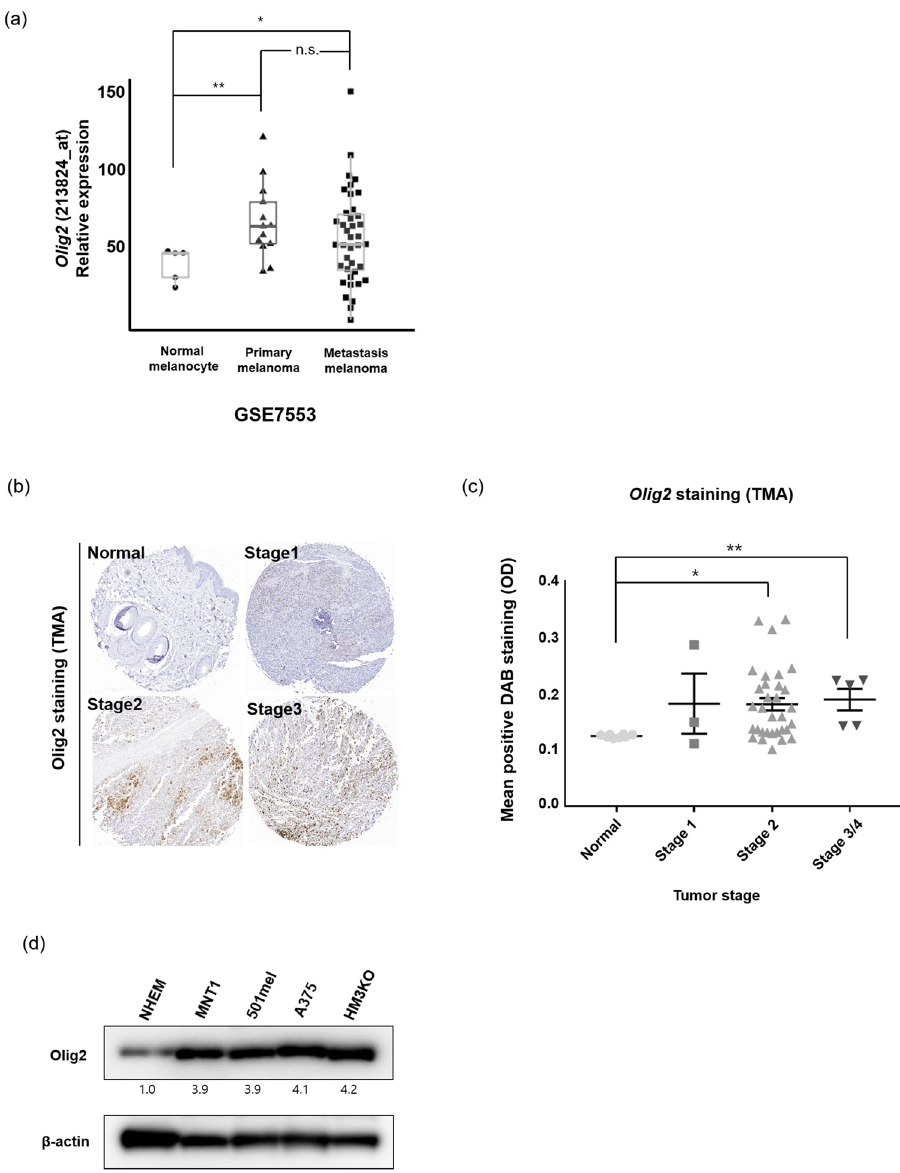
Figure 1. Olig2 was upregulated in melanoma. ( a ) The levels of Olig2 was determined by analysis of GSE7553 public dataset containing the gene expression of normal melanocyte (n = 4), primary melanoma (n = 14) and metastatic melanoma (n = 40). The data was analyzed using Wilcoxon signed-rank tests (ns: not significant, * p < 0.05; ** p < 0.01 versus Normal) ( b ) IHC analysis of Olig2 in normal skin (n = 8) and malignant melanoma skin (n = 40) tissue sample was performed and ( c ) the representative graph was shown. p values were analyzed using unpaired Student’s t-test (* p < 0.05; ** p < 0.01) ( d ) Normal human melanocyte (NHEM) and four human metastatic melanoma cells were lysed with lysis buffer. Olig2 protein expression was detected by western blot analysis with Olig2 (H-10)